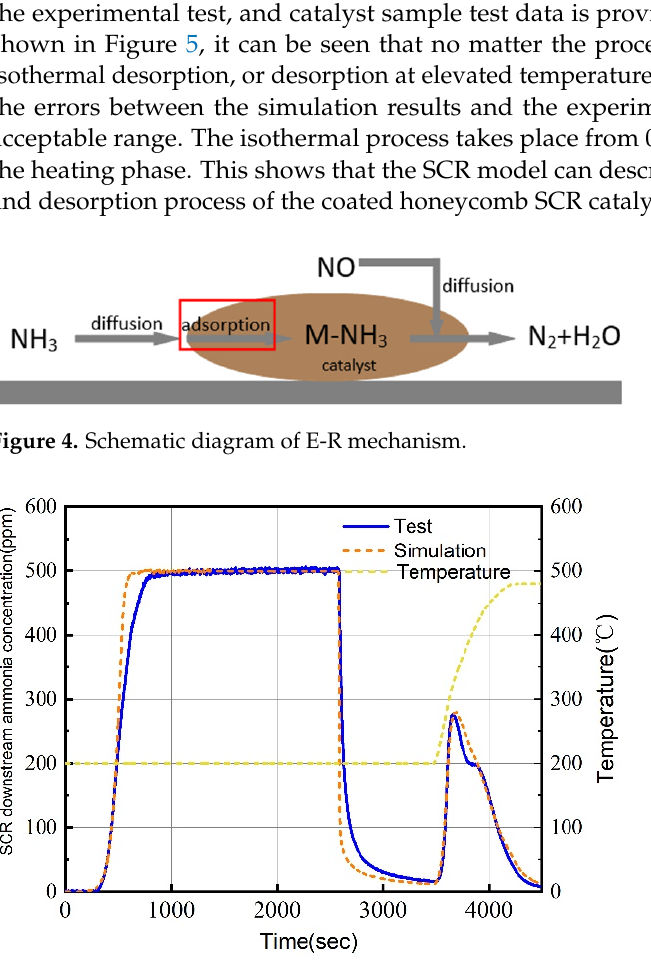
Figure 5. Comparison between NH 3 adsorption and desorption experiment and simulation results.